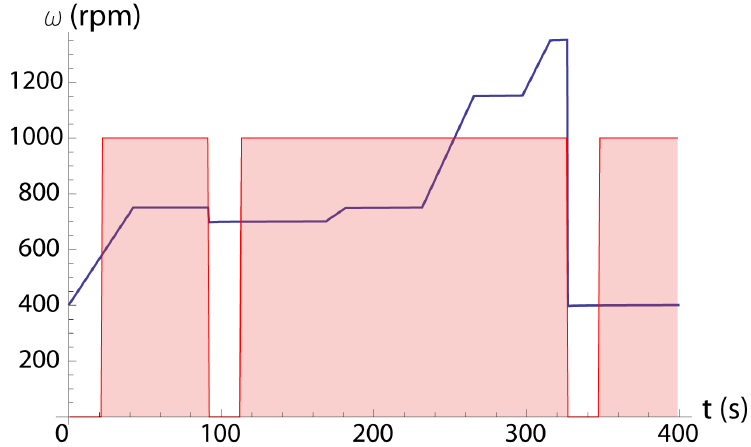
Figure 14: Vacuum pump engagement condition during extra-urban